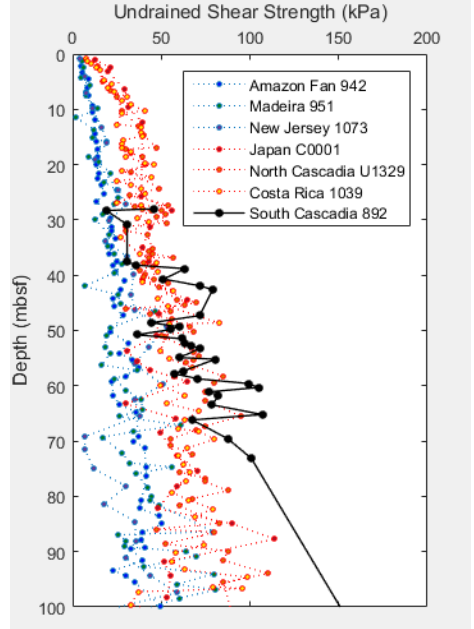
Figure 2. Plot of the vane peak undrained shear strength for the upper 100 meters below seafloor for passive margins (blue) and active margins (red) with ODP Leg 146 Site 892 overlain (black). This plot suggests the pre-failure sediment of the 44 North Slide could have had a similar profile of relatively strong shear strength. Figure modified from Sawyer and DeVore, 2015 [24].